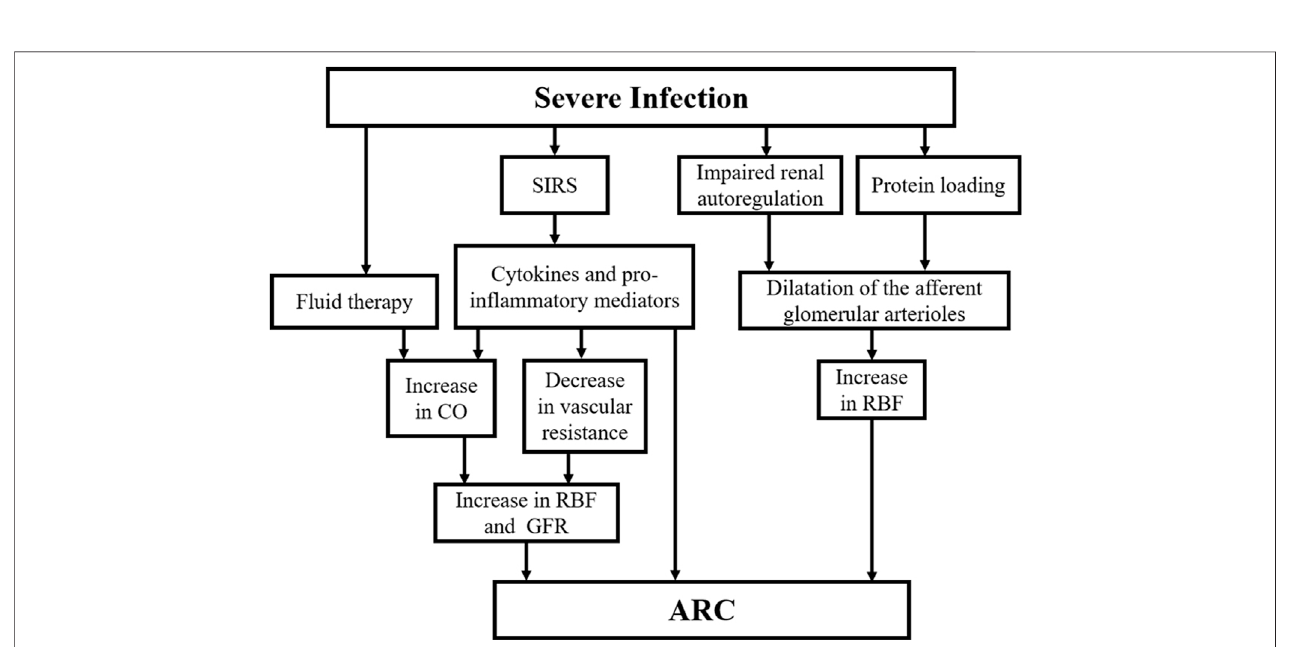
Frontiers in Pharmacology |